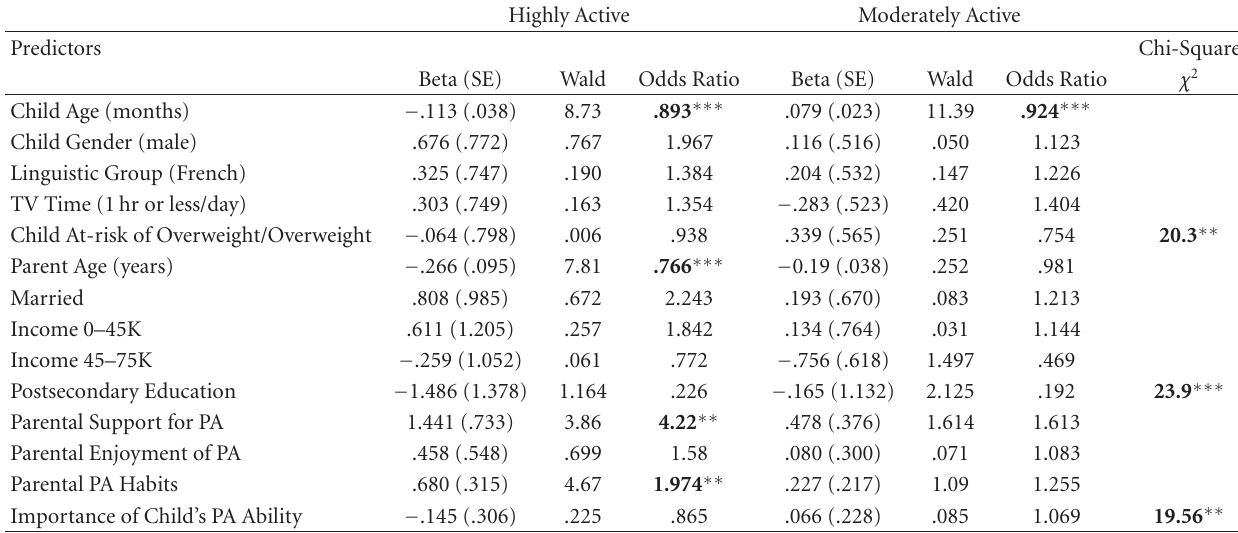
Table 2: Multinomial logistic regression predicting parents’ perception of their child PA intensity